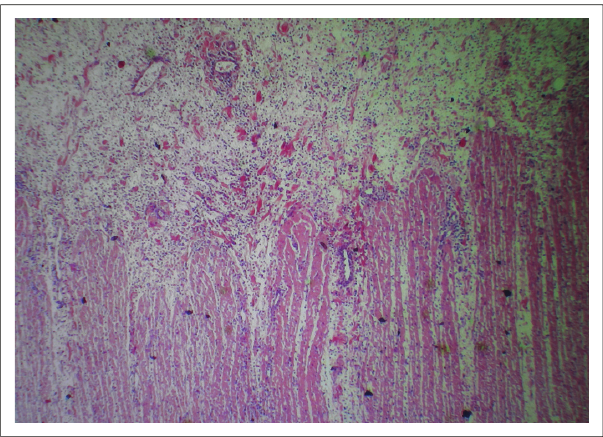
FIGURE 4: Histology of the terminal ileum, demonstrating inflammatory cell invasion through all layers of the intestine and crypt distortion, which is consistent with Crohn’s disease (Hematoxylin-eosin x